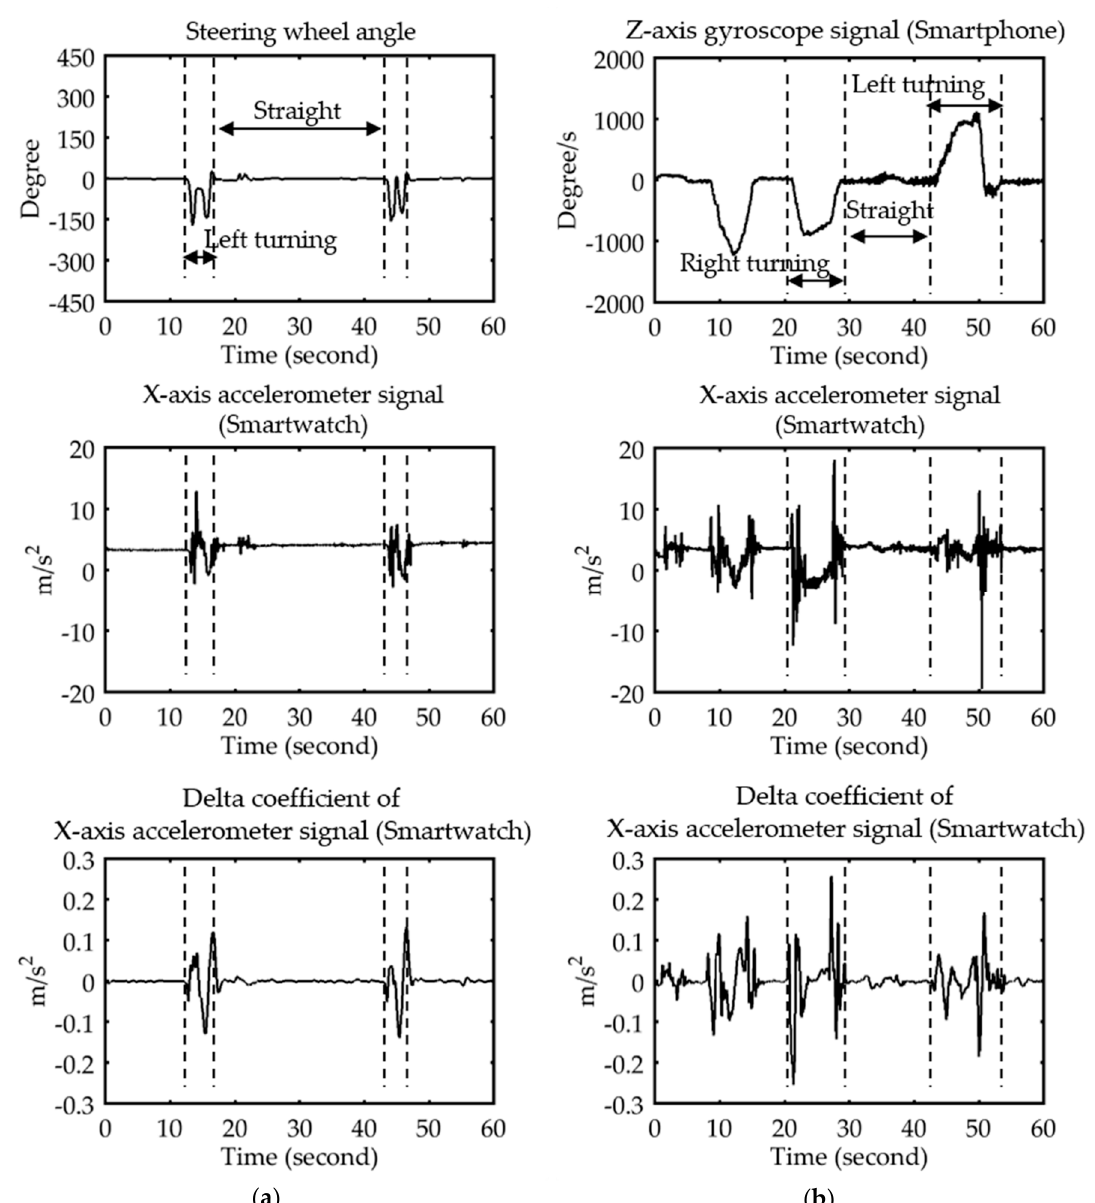
Figure 5. X-axis accelerator and its dynamics for the segment of a single driver. ( a ) Simulated environment. ( b ) Real environment.